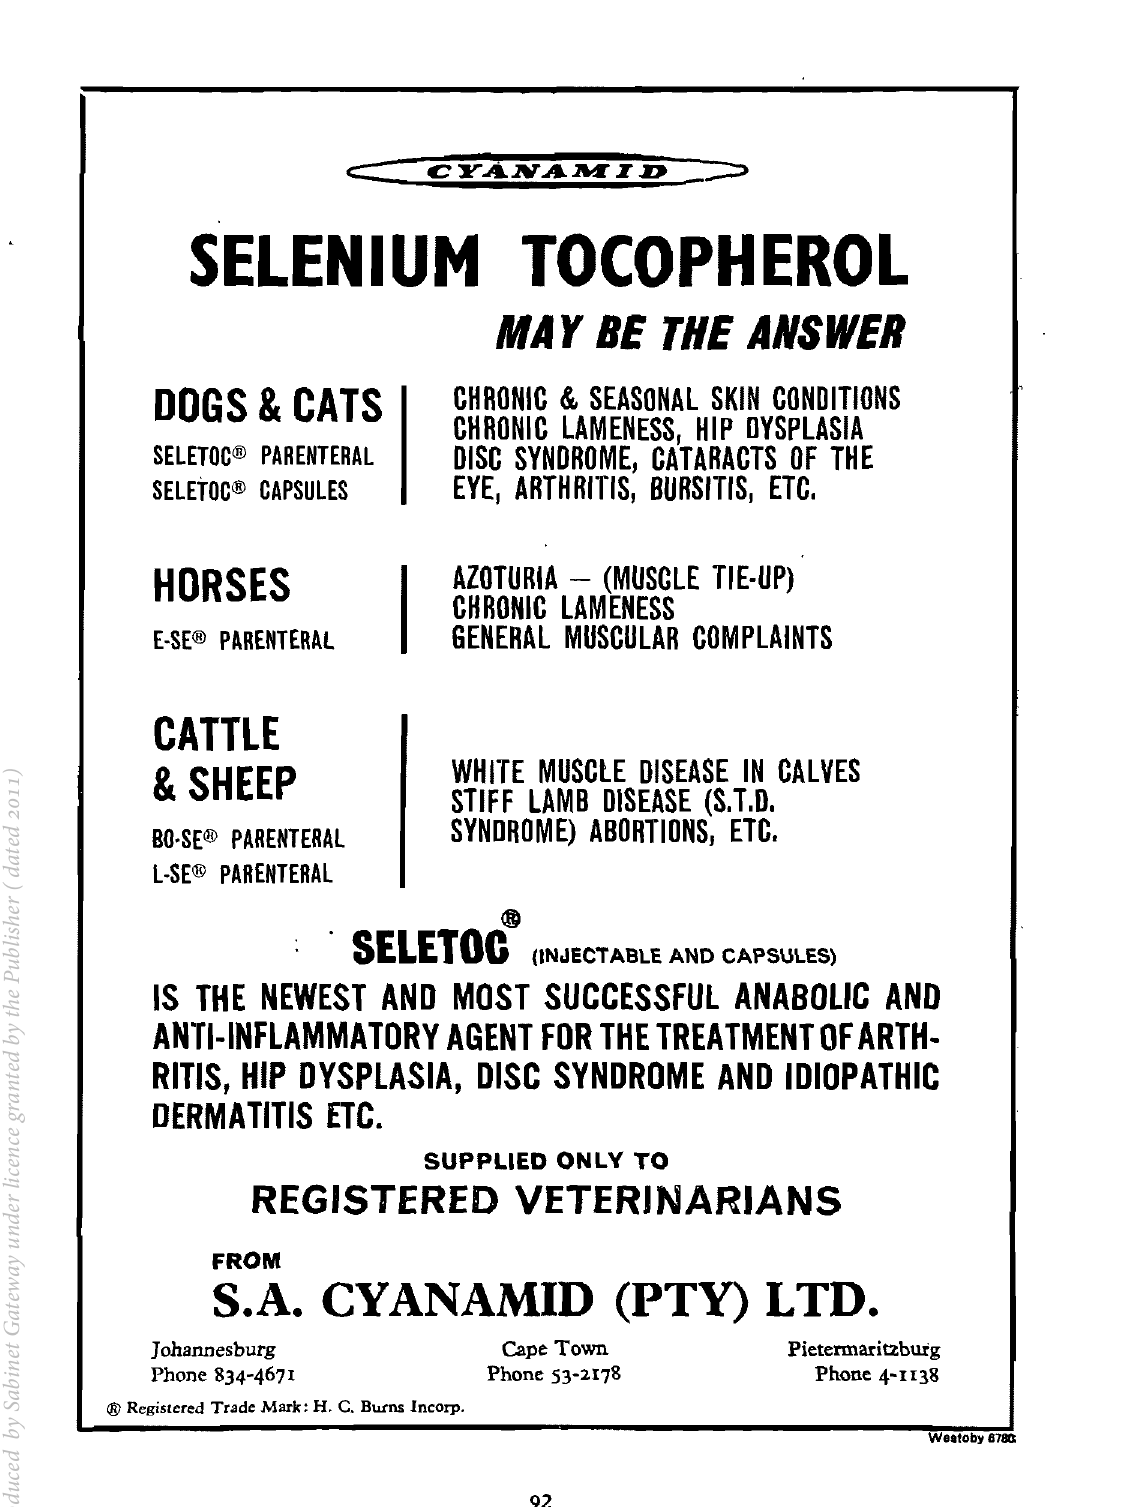
SELEtOC® CAPSULES